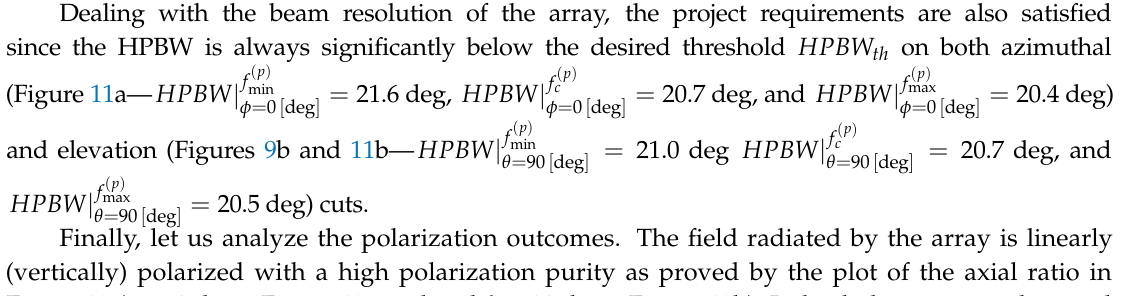
Figure 8. Planar array assessment ( N = 25, gain pattern at ( a ) f = f